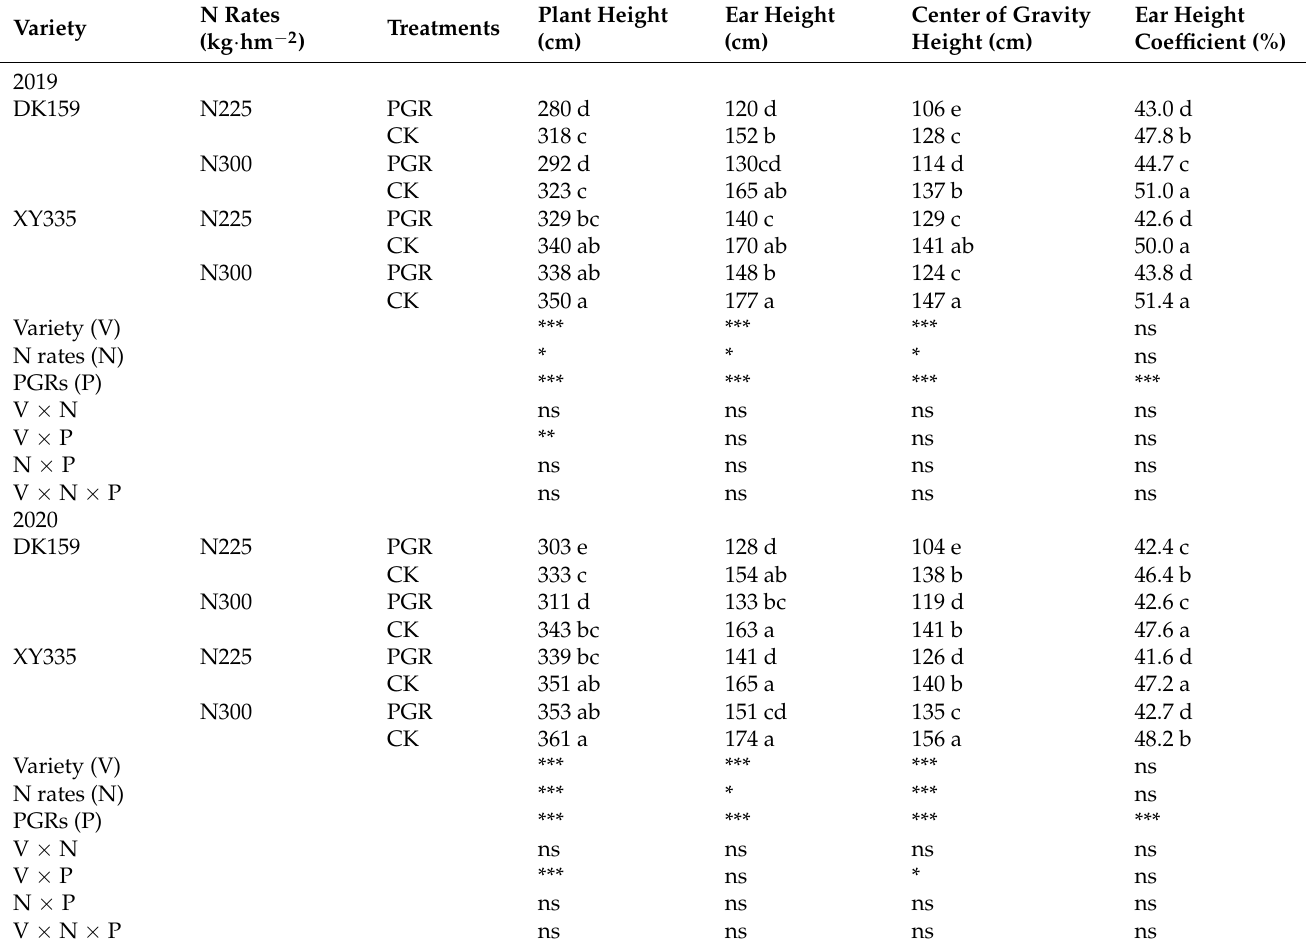
Table 1. Effects of PGRs and nitrogen fertilizer on the agronomic characteristics of maize